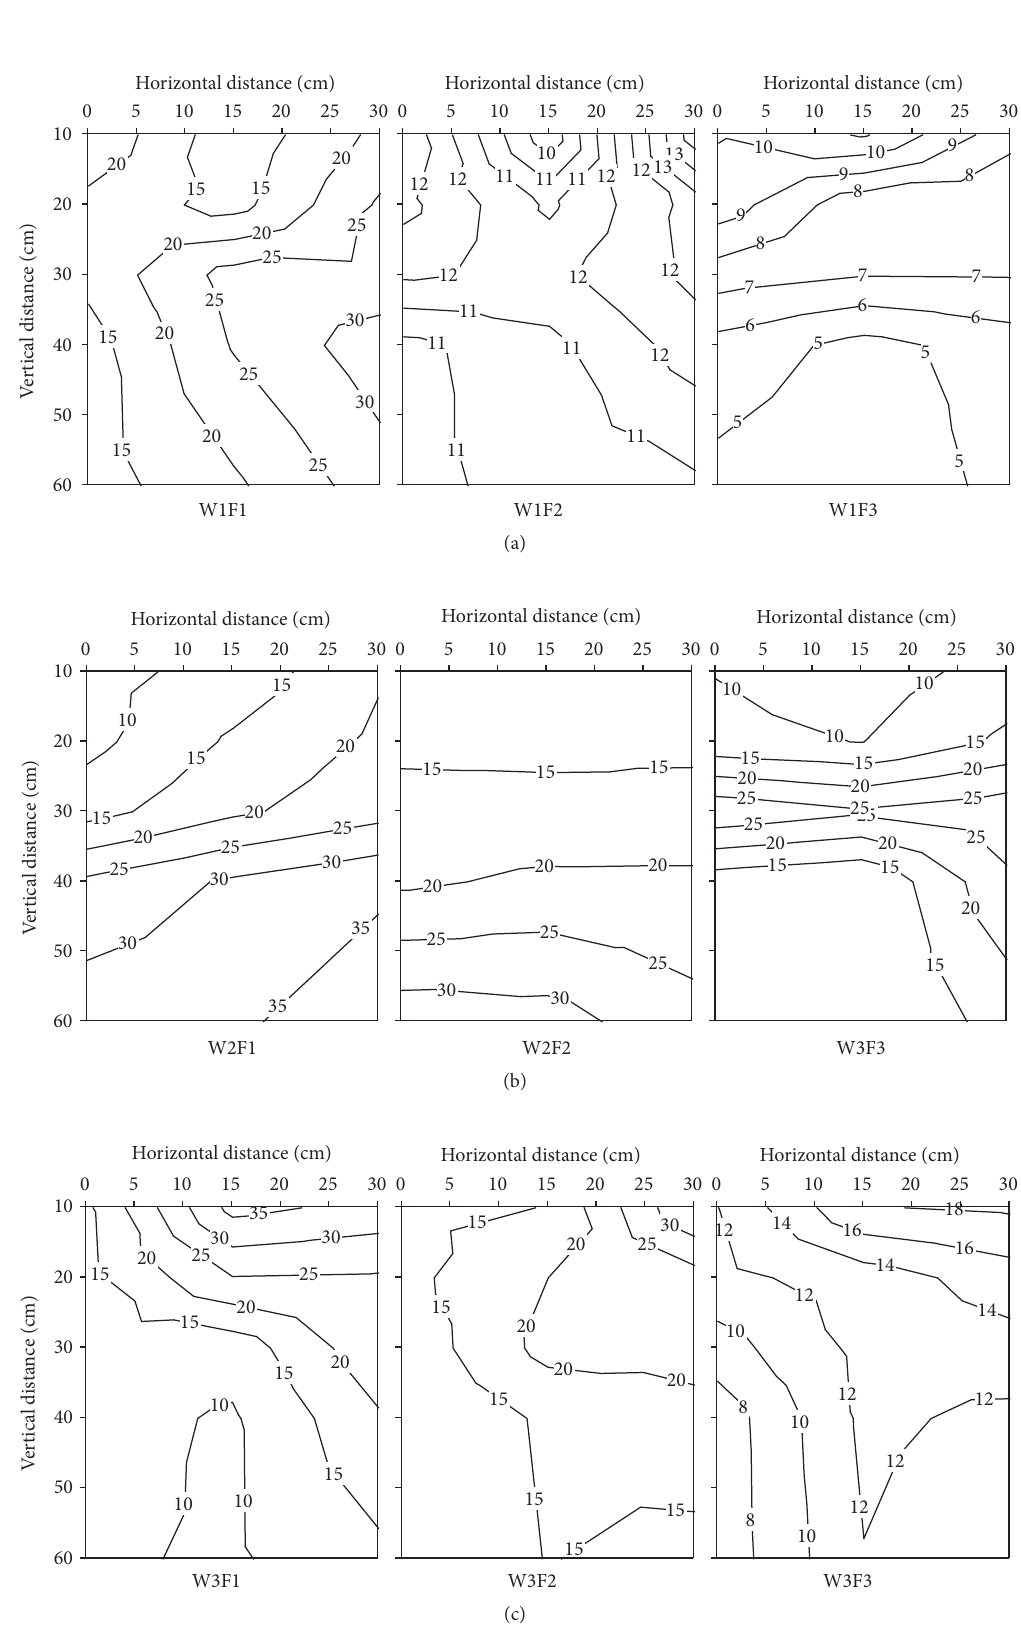
Figure 6: The effects of different irrigation and fertilization on vertical distribution of soil NO 3− -N content in root zone soil of different treatment at 117 days after transplanting in 2012. W1: 100% ET 0 , W2: 75% ET 0 , and W3: 50% ET 0 ; F1: N240–P 2 O 5 120–K 2 O150 kg hm −2 ; F2: N180–P 2 O 5 90–K 2 O112.5 kghm −2 ; and F3: N120–P 2 O 5 60–K 2 O75 kg hm −2